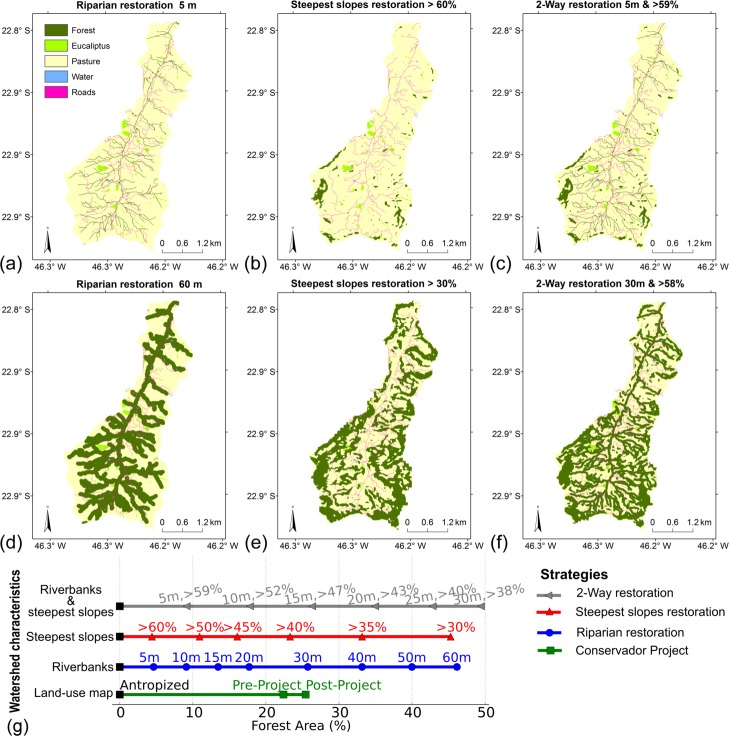
Simulated land use scenarios using different restoration strategies: (left) Riparian, (center) Steepest Slopes, and (right) in the two previous ways (2-Way).Other intermediate scenarios appeared in (g), which shows land-use scenarios as a function of the forest area of the watershed, for each restoration strategy: Conservador Project (in green), Riparian (blue), Steepest Slopes (red), and in the two previous ways (2-Way, gray).